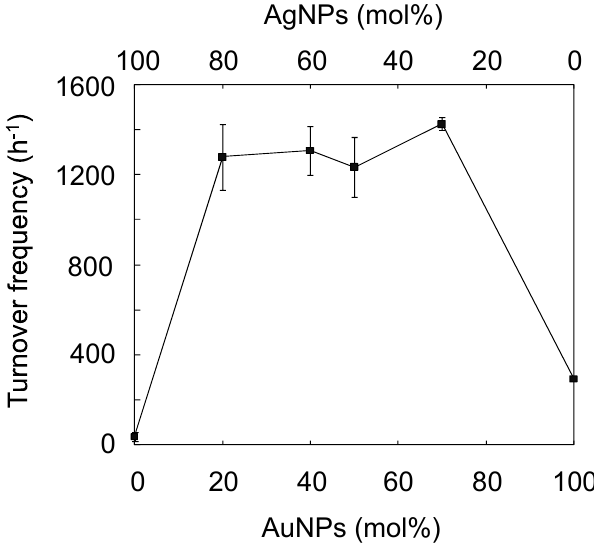
Figure 6. Turnover frequencies (TOFs) for the AuAgNPs @ ZnO whiskers in the reduction of 4-NP, as a function of Au and Ag mol%. The total amount of Au and Ag: 0.1 µmol, 4-NP: 15 µmol, NaBH : 3.0 mmol. 4 AgNPs